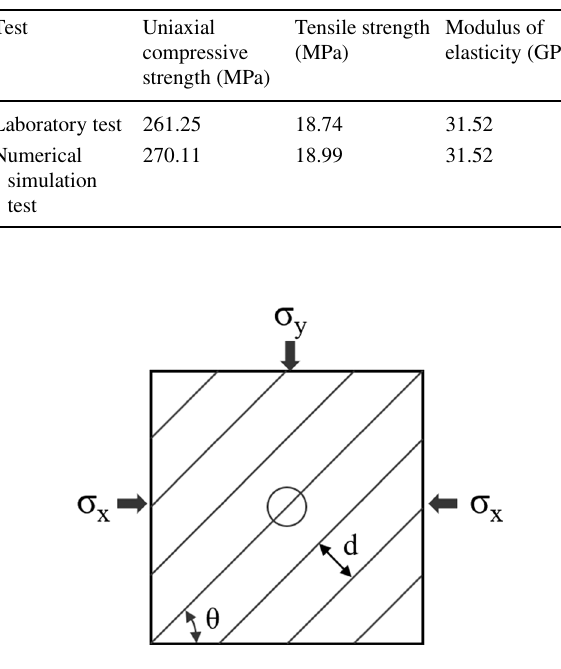
Fig. 5 Schematic diagram of the scheme